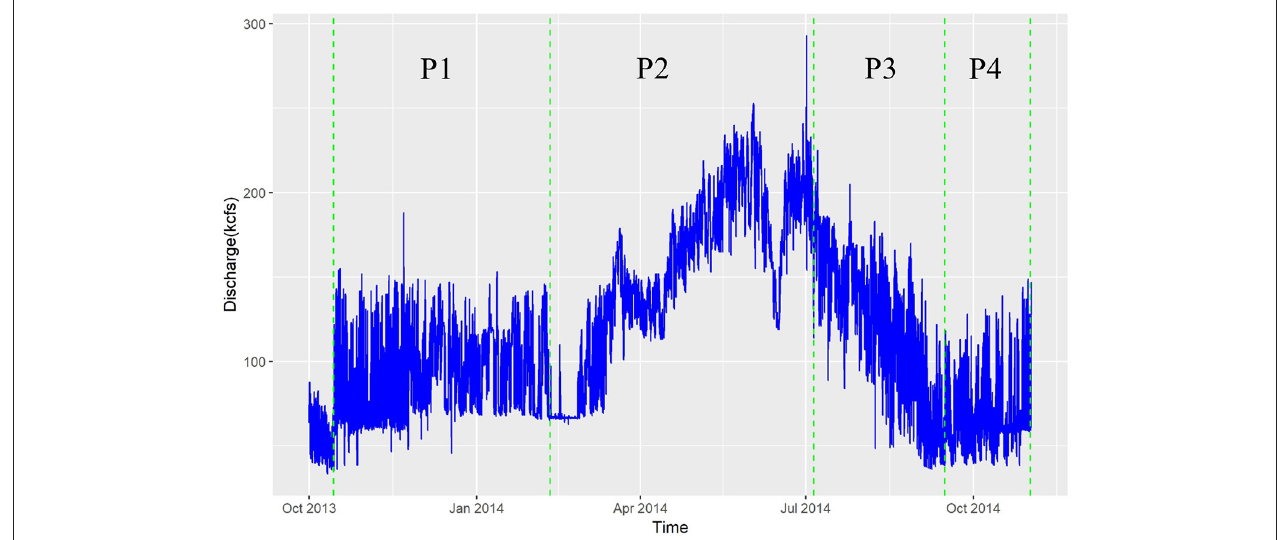
FIGURE 3 | Discharge from U.S. Geological Survey gaging station 12472800, Columbia River below Priest Rapids Dam, WA for the period of approximately water year